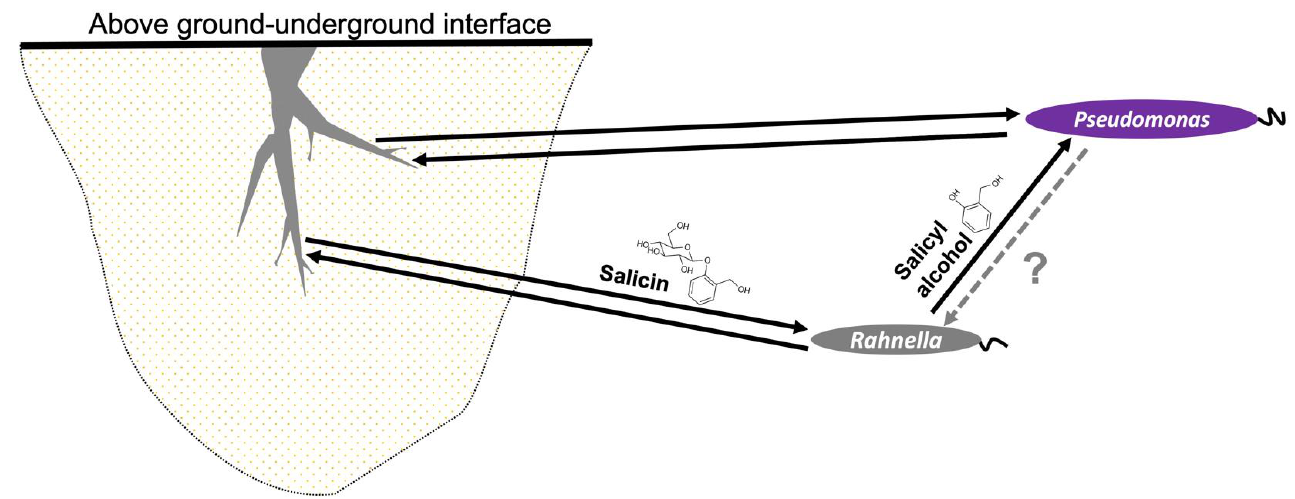
Figure 5. Proposed model of mechanism of microbial recruitment of P. fluorescens GM16 on Populus by the facilitator R. aquatilis OV744 through PGs such as salicin. In the suggested model, plants pro- vide PG carbon substrates to recruit bacteria. In the Populus – Rahnella – Pseudomonas model, Rahnella can utilize salicin produced by Populus and releases salicyl alcohol as a by-product. Salicyl alcohol is then utilized by Pseudomonas . In return, neither beneficial nor harmful activity has yet been ob- served. Both Pseudomonas and Rahnella have demonstrated plant-growth promoting properties sug- arrows suggest beneficial interaction and the grey, dotted arrow represents yet unknown interac- tion.